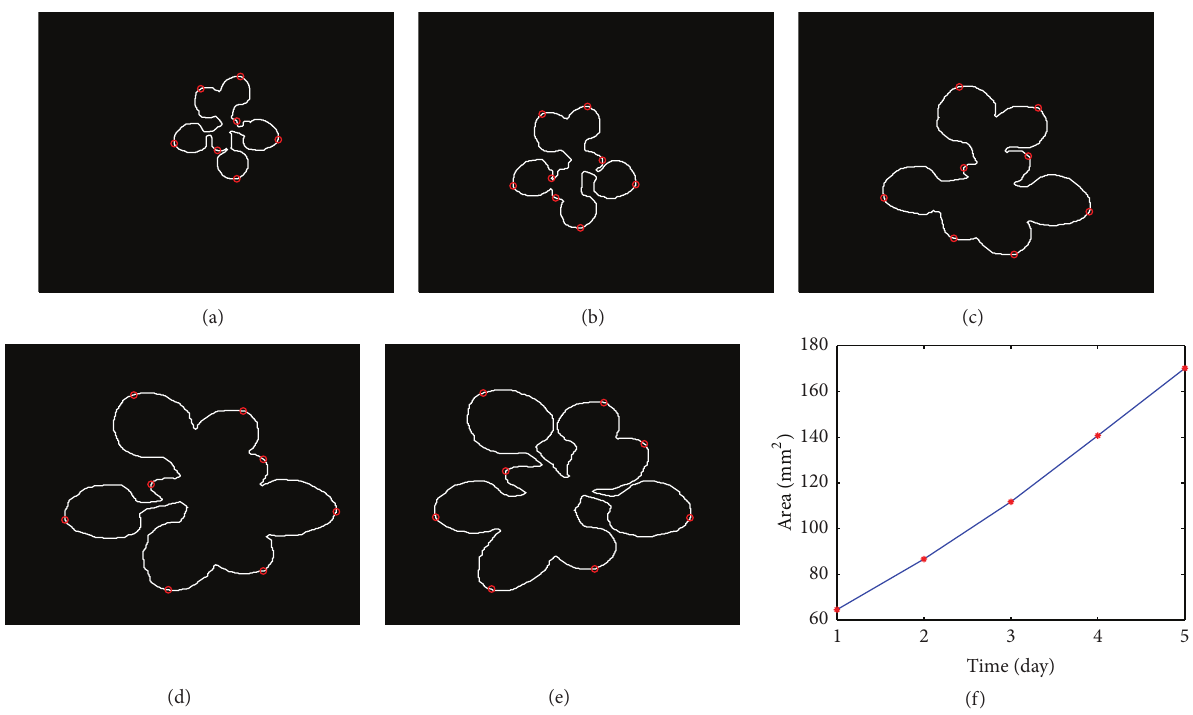
Figure 5: Growth simulation. (a)–(e) Contour reconstruction during 5 days. The leaves apexes are marked with red dots. (f) Increase of the total area of the